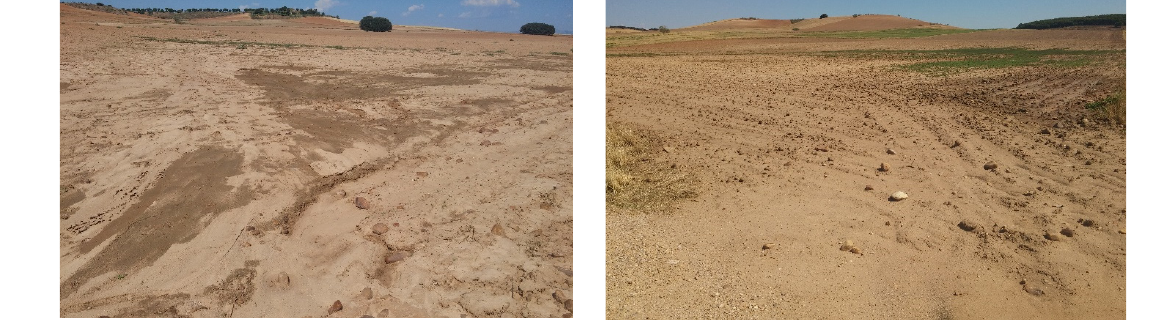
Image 1: Erosion processes. Example of a red zone